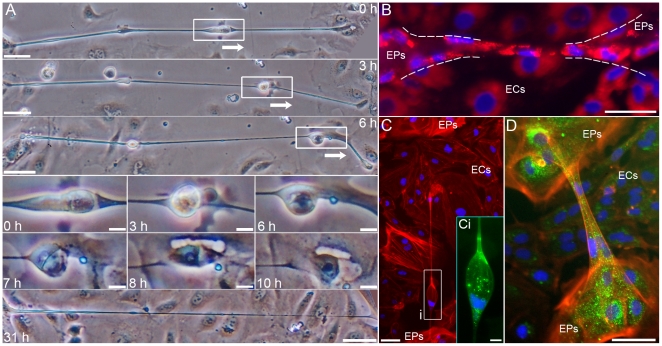
Cell migration via EP bridges.
A: An individual cell migrating over 10 h through an EP bridge that connects EP islands (not a connection between only two cells). The cell expanded the elastic structure of the EP bridge, which returned to original size after the cell passed (0–6 h). The migrating cell exited the EP bridge through an elastic sheath and migrated into the EP island (7–10 h). EP bridge length remained relatively stable over 31 h as ECs grew underneath the bridge. The EP bridge measured 623 µm at 0 h and 562 µm at 31 h. B: Lysosome (red) and nucleus (blue) staining in EPs/ECs show nuclei co-localized with lysosomes in an EP bridge connecting two EP islands. C–D: F-actin (red), Golgi marker (green), and nucleus (blue) immunostaining show co-localization of nuclei and Golgi suggesting an individual cell expanded the EP bridge structure (C-Ci), while multiple cells were within another EP bridge (D). Scale bars: (A 0 h and 31 h, B, C, D), 50 µm; (A subpanels, Ci), 10 µm.